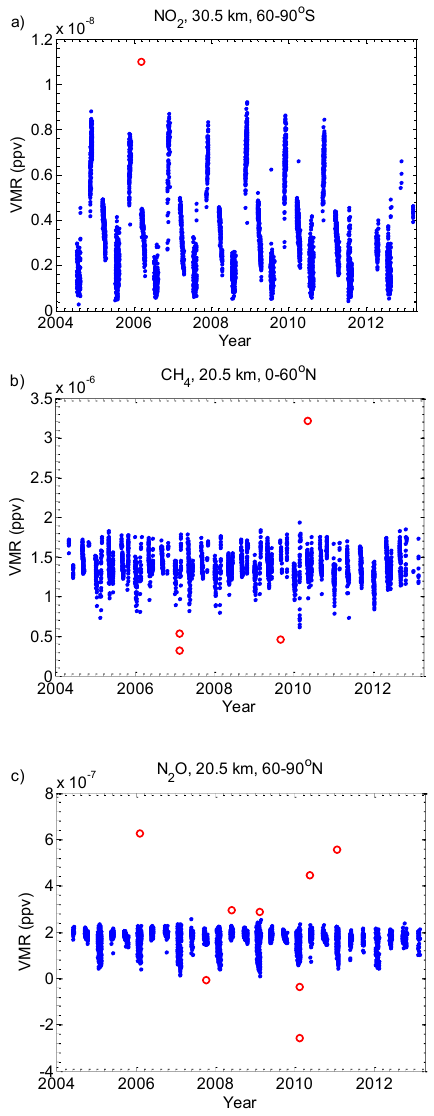
Figure 5. Sunrise ACE-FTS data for the same data subsets as Fig. 4. The red circles are data that have been determined to be unnatural outliers as per the EDFs, and the blue dots are the inlying